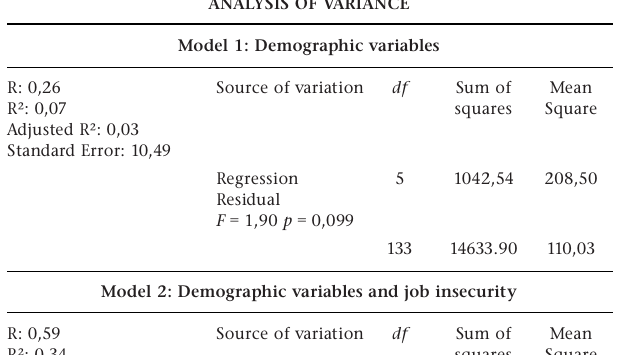
Adjusted R²: 0,03